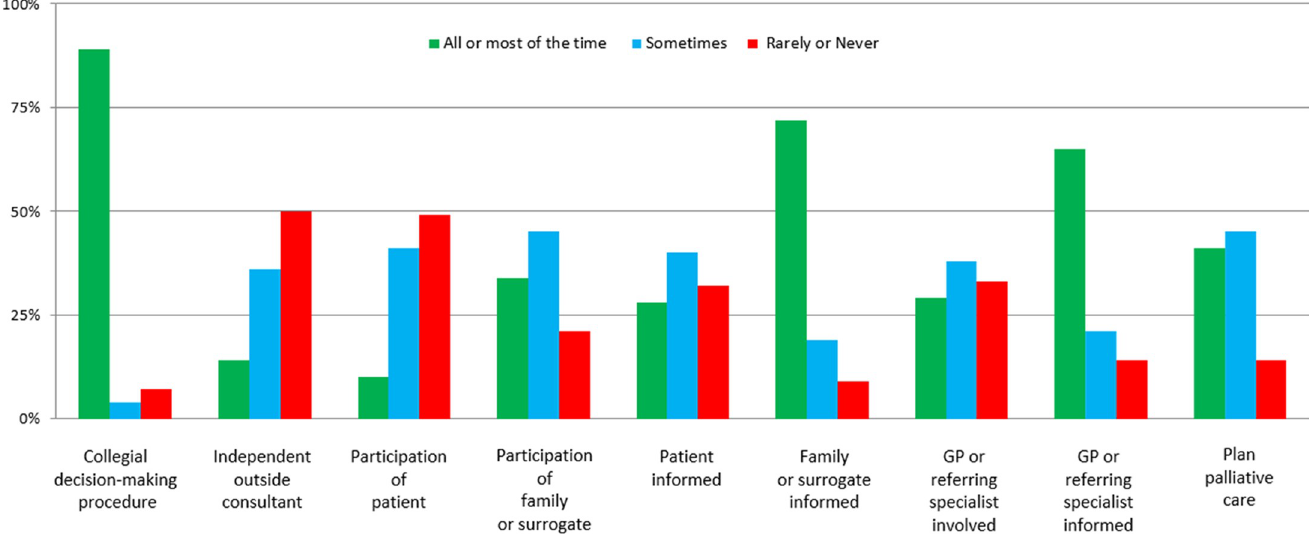
Fig 1. Responses to the questionnaire regarding how re-admission decisions are taken in the intensive care unit (N = 165 respondents). GP, general practitioner.